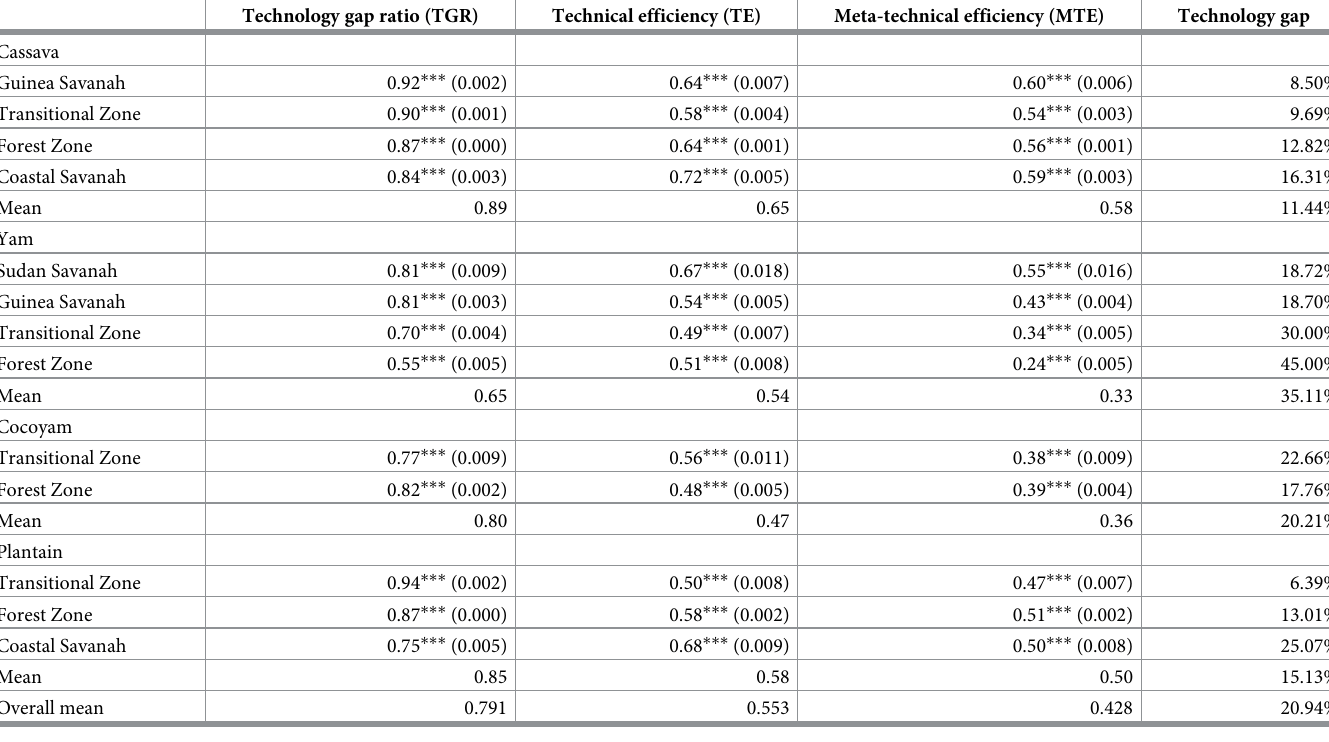
Table 4. Ghanaian starchy staple production technology level and technical efficiency across ecologies